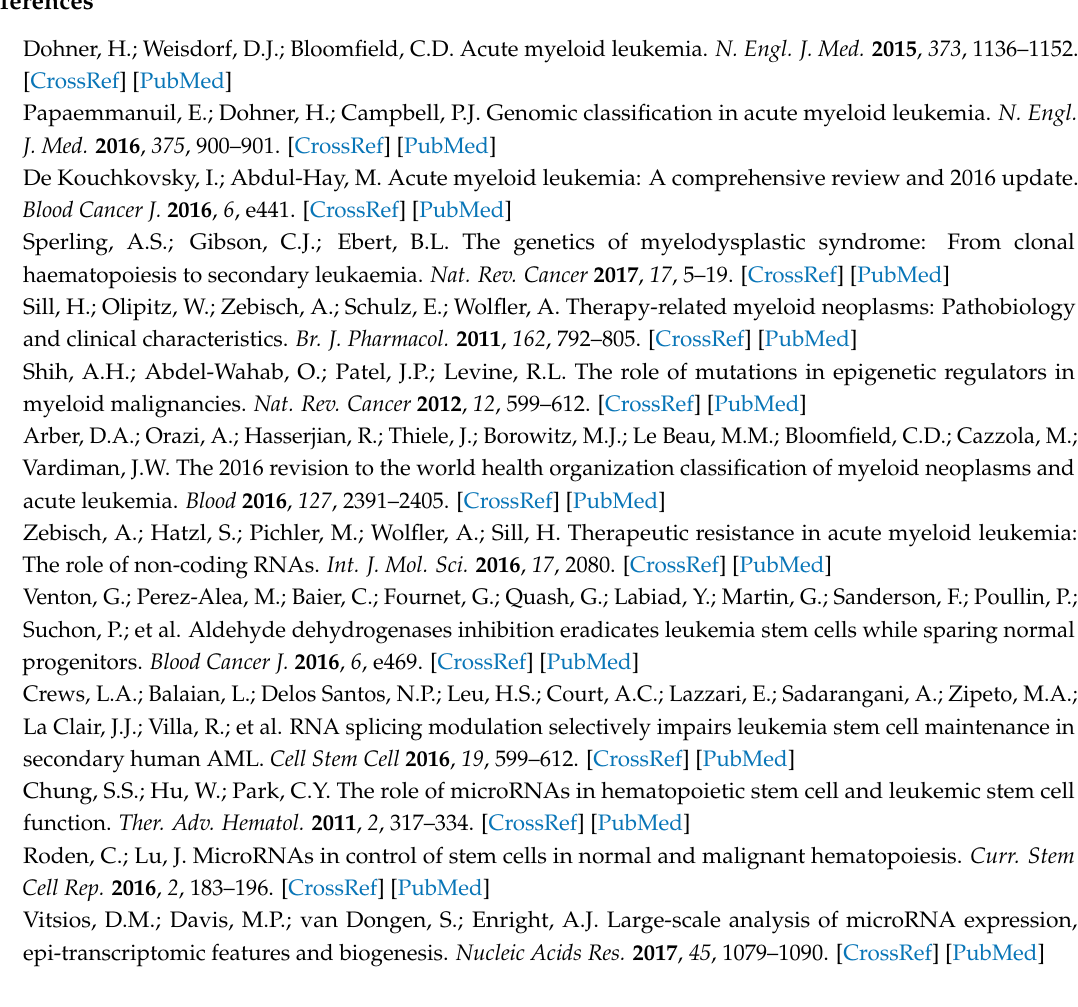
Conflicts of Interest: The authors declare no conflict of